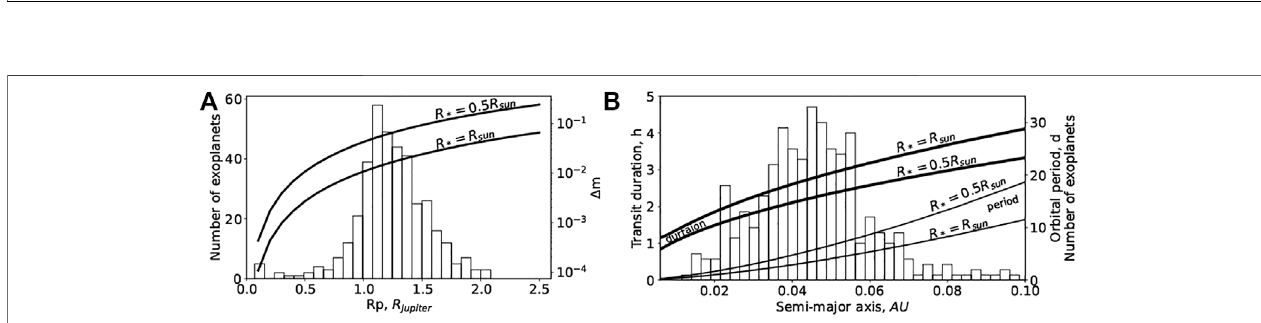
FIGURE9| Maximumbrightnessdimmingofthehoststarduringatransitevent Δ m versustheexoplanetradius( (A) ,rightaxis)and (B) transitduration(leftaxisand bold lines) and orbital period (right axis and thin lines) versus the semi-major axis of the exoplanet orbit for the stars of solar radius and those two times smaller. Also shown are the histograms of the distribution of con fi rmed transiting exoplanets (NASA, 2022) detected by ground-based facilities by the exoplanet radius ( (A) , left axis) and by the semi-major axis of their orbits ( (B) , right axis).